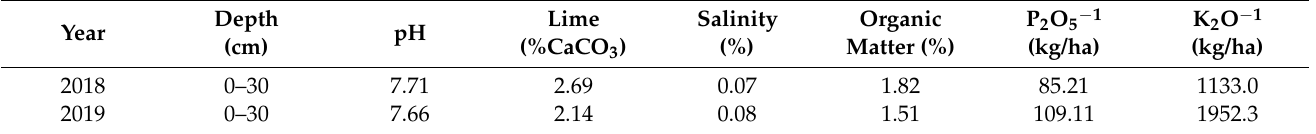
Table 1. Physical and chemical properties of soil in the experimental area of Nur Sultan,